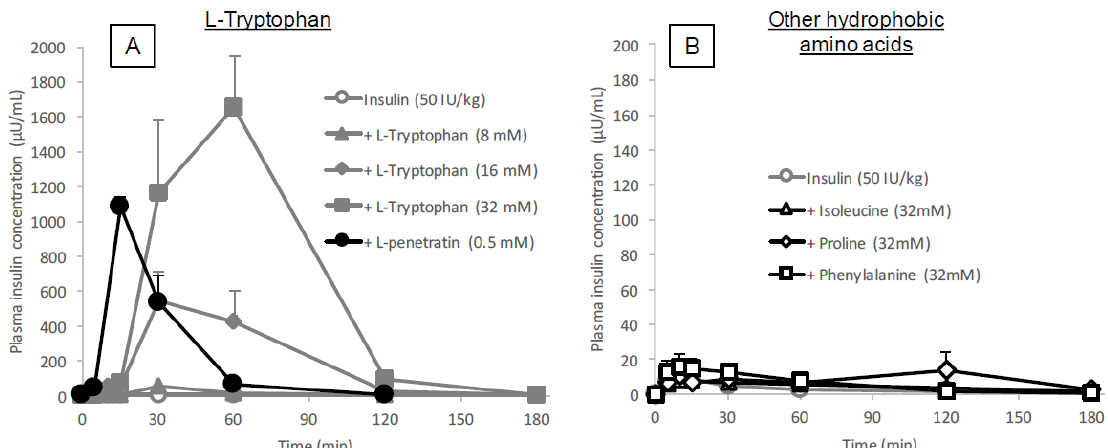
Figure 1. Time profiles of plasma insulin concentration after in situ administration of insulin (50 IU/kg) with or without L -tryptophan, L -penetratin or other hydrophobic amino acid additives into rat ileal loop. Panel ( A ), L -tryptophan (8–32 mM) or L -penetratin (0.5 mM); panel ( B ), hydrophobic amino acids ( L -isoleucine, L -proline and L -phenylalanine, 32 mM). Each data point represents the mean ± SEM of N = 3–8, except for the group with L -tryptophan (8 mM, N = 2). Table 1. Pharmacokinetic parameters following in situ administration of insulin with various amino acid additives, L -penetratin, or after pretreatment of amino acids or control reagents. Experiment